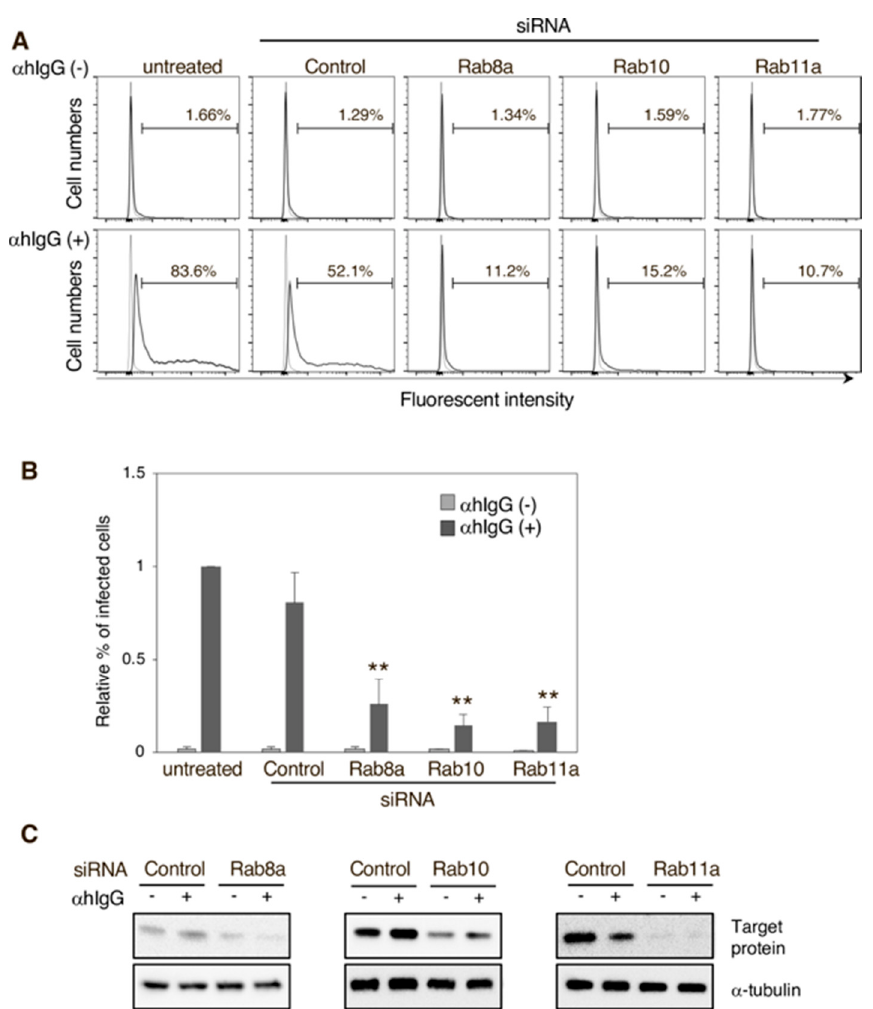
Figure 4. The e ff ect of Rab GTPase downregulation on the release of infectious EBV virions. i293 / 2089 cells transfected with or without Rab8a, Rab10, or Rab11a siRNAs were treated with tamoxifen for 48 h to induce the EBV lytic cycle. Their supernatants were then harvested and added to Daudi − cells. Two days later, the percentage of GFP-positive Daudi − cells was analyzed by flow cytometry. ( A ) Representative histograms are shown. As a control, Daudi − cells were incubated without the supernatants (thin lines). ( B ) The average infection frequencies and standard deviations are also represented. Results reflect three independent experiments. Statistical di ff erences were assessed using Student’s t test and are represented as ** p < 0.01. ( C ) Downregulation of Rab proteins was confirmed by Western blot.